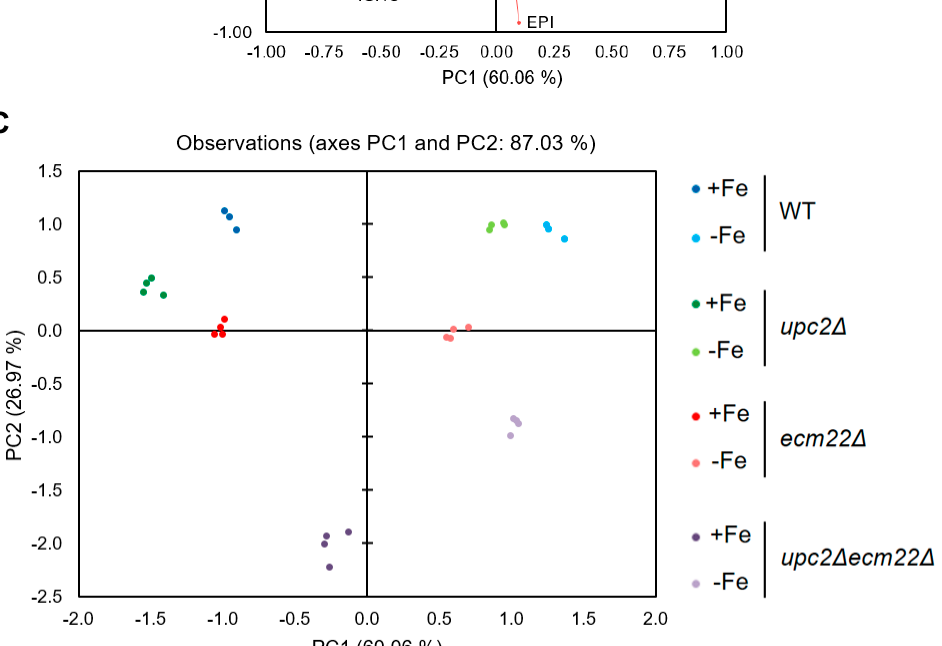
Figure 4. Iron deficiency modifies the sterols profile of upc2 and ecm22 mutant cells. Yeast wild-type (WT, W303), upc2 ∆ , ecm22 ∆ , and upc2 ∆ ecm22 ∆ cells were cultivated at 30 ◦ C for 8 h in SC with 20 µ M FAS (+Fe) or 100 µ M BPS ( − Fe). Then, sterol intermediates were extracted and quantified as indicated in the Material and Methods section. ( A ) Levels of intermediate sterols in each strain under both +Fe and − Fe conditions, represented as a percentage of the total sterol content. Squalene, lanosterol, 4,4-dimethylzymosterol (4,4-DIME), zymosterol, episterol, and ergosterol relative levels are represented. Data show the average and SD of four independent experiments. Different letters represent statistically significant differences between each strain for a specific sterol ( p -value < 0.05). ( B , C ) Principal component analysis (PCA). Biplots of varimax rotated PCA for each strain on which sterols variables ( A ) and observations ( B ) are plotted. SQ, squalene; LST, lanosterol; 4,4-DIME, 4,4-dimethylzymosterol;